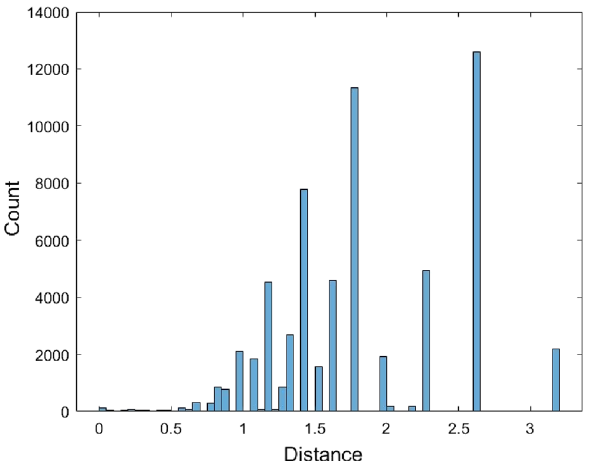
Figure 1. The histogram of the JC model distance